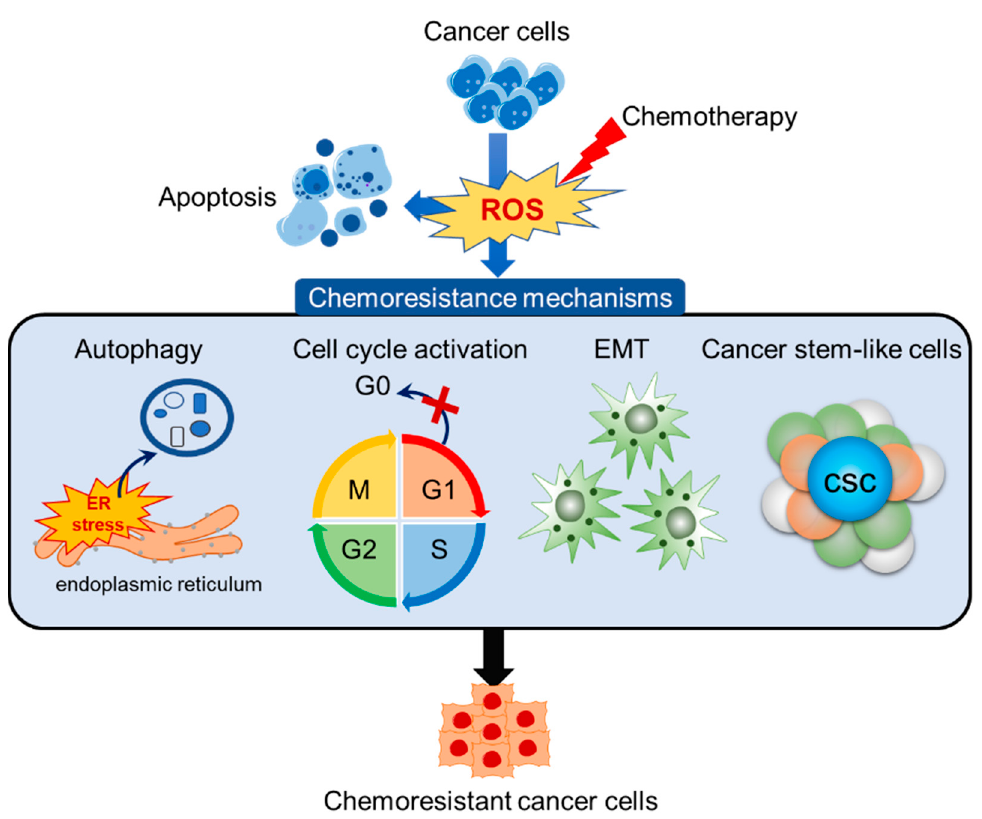
Figure 3. Redox homeostasis between generation and elimination of ROS. Cancer cells increase ROS-mediated apoptosis when exposed to chemotherapy treatments. Some cancer cells adapt to fluctuating ROS states through chemoresistance mechanisms. Activation of autophagy by ER stress gets rid of damaged organelles and protein aggregation. Cell cycle activation by the ignored entrance of the G0 phase increases cell proliferation in cancers. Epithelial-mesenchymal transition (EMT) enhances migration to other organs for the escapement of damaging environments. Cancer stem-like cells (CSCs) increase the expression of drug metabolic enzymes / transporters for cell survival from drug-mediated apoptosis. The specific microenvironment, called the niche, of CSCs are protected from chemotherapy. These mechanisms lead to the birth of chemoresistant cancer cells.